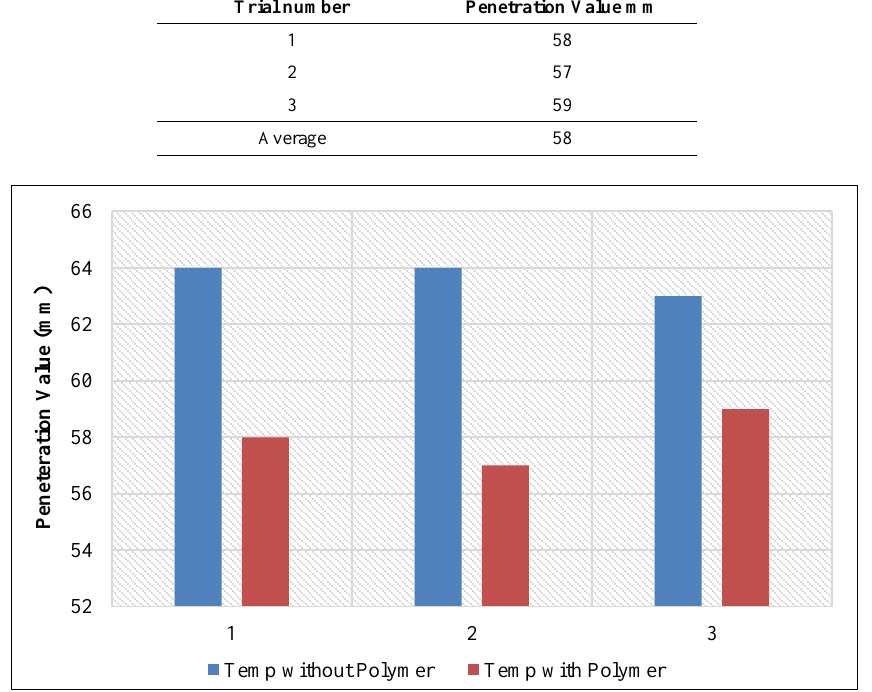
Figure 20. Penetration test results